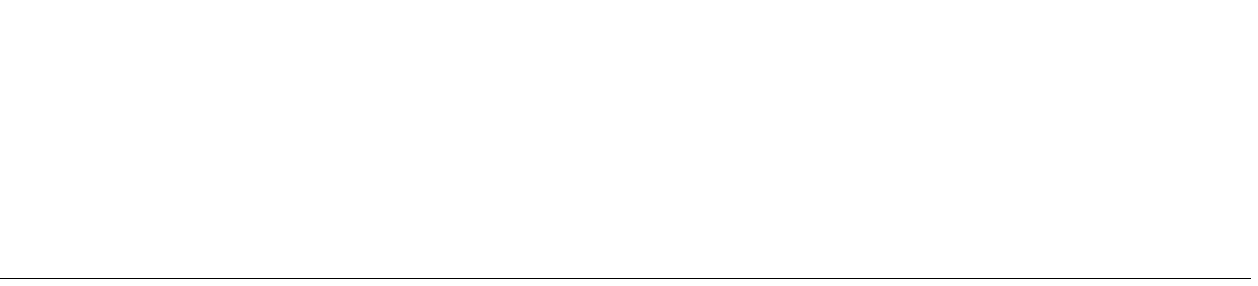
FIGUREA4 | Representative RNA in-situs fromAllen Brain mouse brain (only P56 time point available) images showing the PC specific expression of voltage-gated calcium channel transcripts, Cacana1a ,